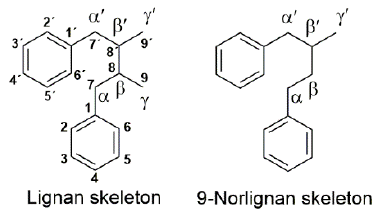
Figure 1. The structure of lignan and 9-norlignan and norlignan.